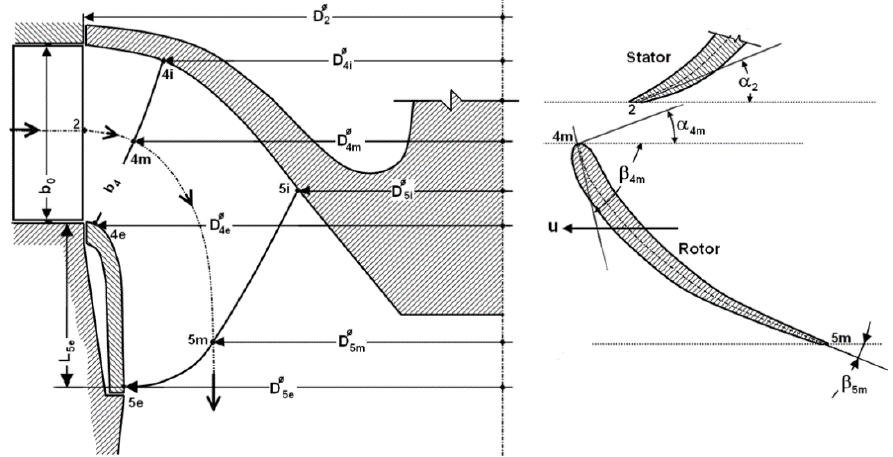
Figure 8. Average flux line and main dimensions and angles for the reaction turbines.